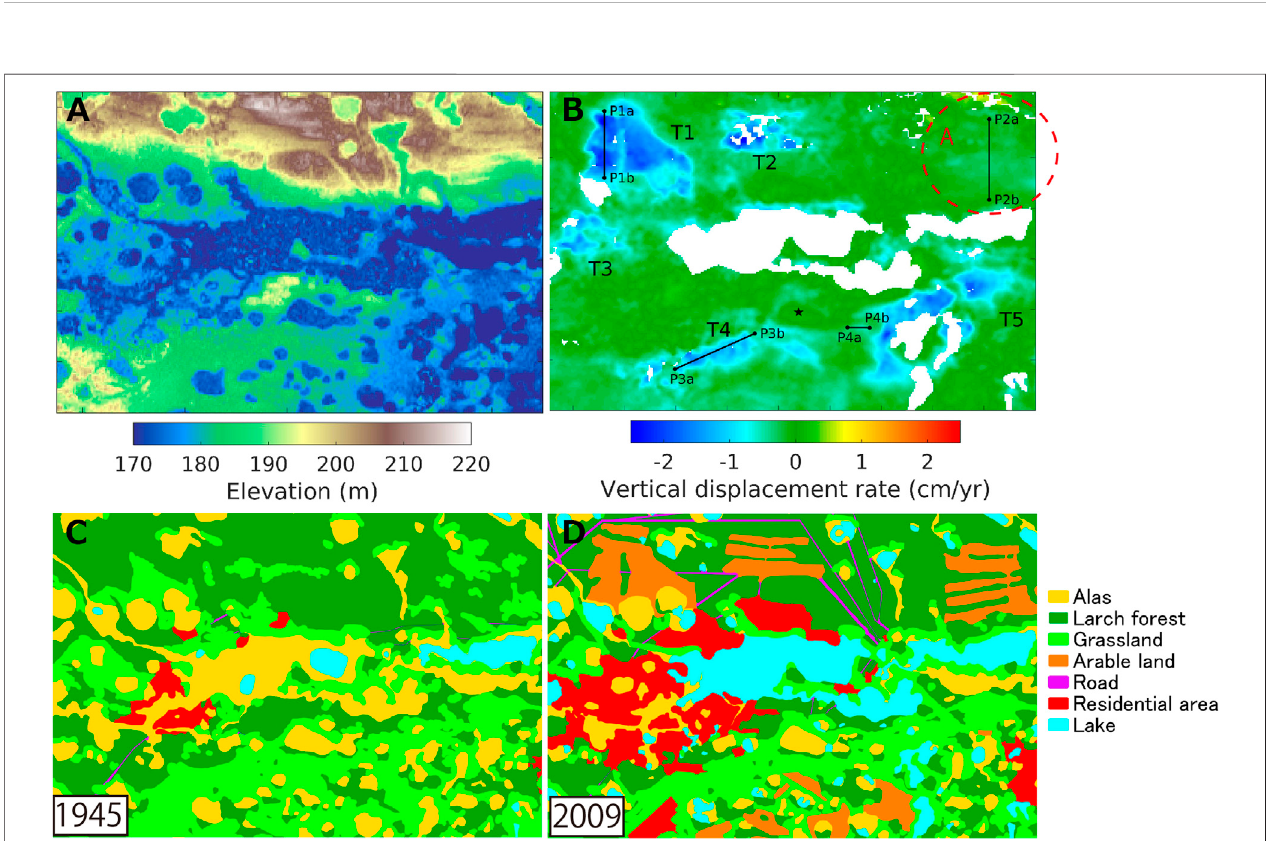
FIGURE 2 | Enlarged view of (A) elevation and (B) vertical displacement rate in Churapcha. P1-P4 indicate transect lines showing pro fi les in Figure 3 . The star indicatesthelocationoftheInSARreferencepoint.ThereddottedovallabeledAindicatesanareaofarablelandwheresurfacesubsidencewasnotdetected. (C) and (D) indicate land classi fi cation in 1945 and 2009, partially modi fi ed from Gorokhov et al. (2011).